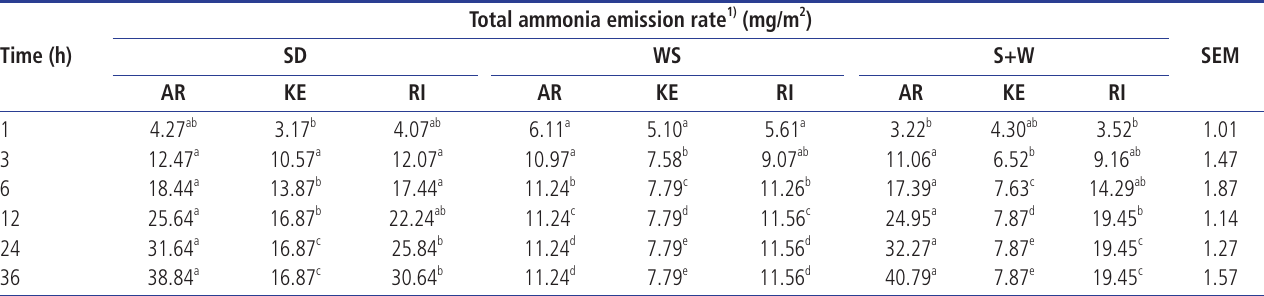
Table 6. Total ammonia emission of bedding materials by the species of pine trees measured by the chamber system Time